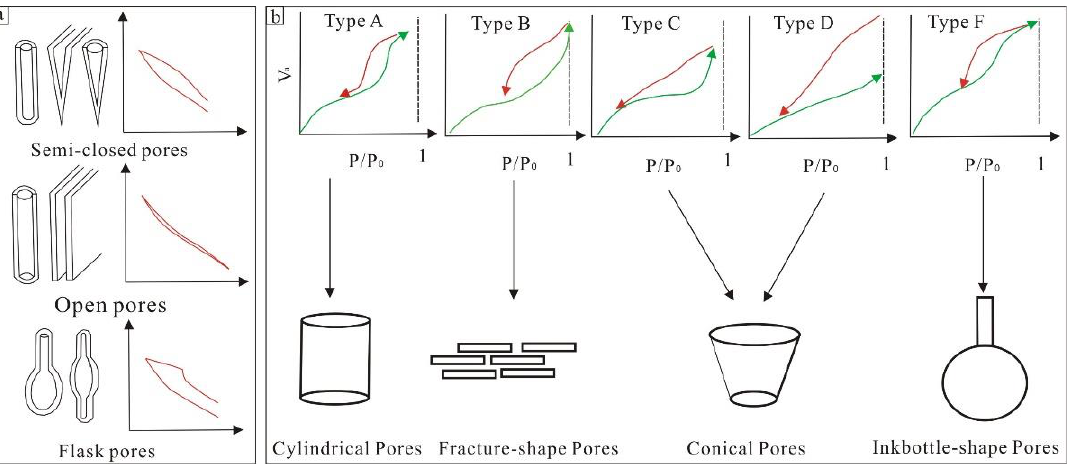
Figure 9. Mercury injection–withdraw curves, N 2 adsorption–desorption curves with their corre- sponding pore shapes. ( a ) Corresponding pore shapes of mercury injection–withdraw curves. ( b ) Corresponding pore shapes of N 2 adsorption–desorption curves (Red line: adsorption curve; Green line: desorption curve).